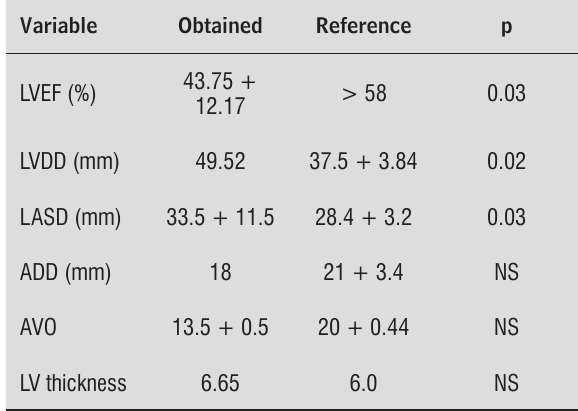
Figure 2 - Comparison of baseline values with the values obtained in the echocardiogram for the variable do left atrium systolic diameter * (LASD), where p = significance level